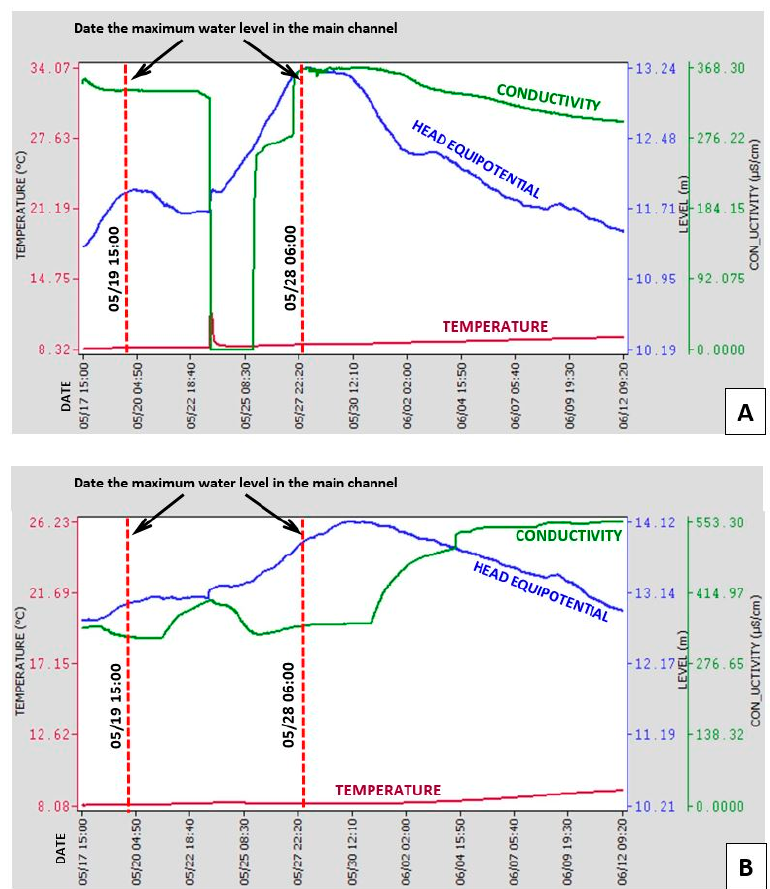
Figure 7. The results of the measurements of head equipotential temperature and electrolytic conductivity in the piezometer located in the crevasse channel ( A ) and in an untransformed terrace ( B ). The red line marks the maximum water level between the embankments (peak of the surge).